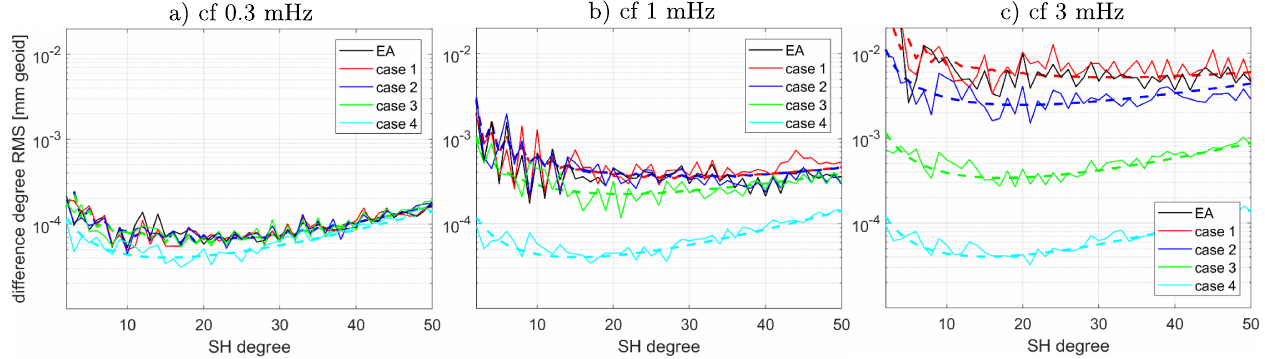
Figure 11. Degree RMS of residual coefficients for a GRACE-type mission under consideration of the static gravity field signal and a hybrid accelerometer with a 1/ f 3 EA noise slope for an EA corner frequency ( a ) of 0.3 mHz ( left ), ( b ) of 1 mHz ( center ), and ( c ) of 3 mHz ( right ). The respective formal errors are shown as dashed lines of the corresponding color.